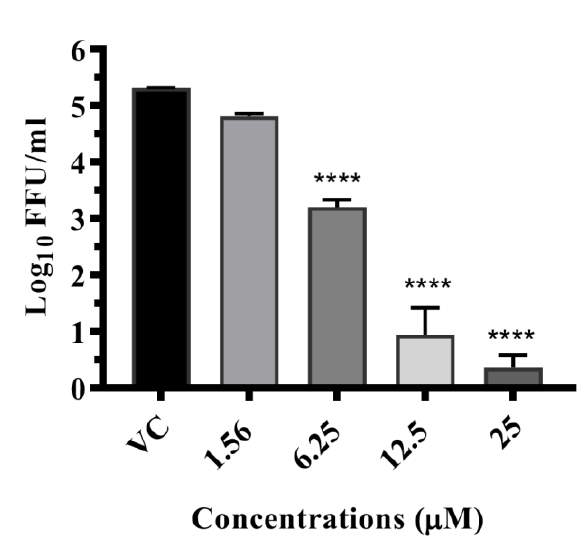
Figure 6. Antiviral effects of doxorubicin under co-treatment condition. The virus was treated with doxorubicin at different concentrations and the virus drug mixture was used for infection. Infected Vero CCL-81 cells were incubated for 120 h after infection. The culture filtrates were used for the FFU assay. Experiments were performed in triplicate at three independent time points. Results were plotted as mean log10 of focus-forming unit/mL ± standard error. All the treatment groups were compared with a virus control (VC) group (infected cells which did not receive drugs). **** p < 0.0001.